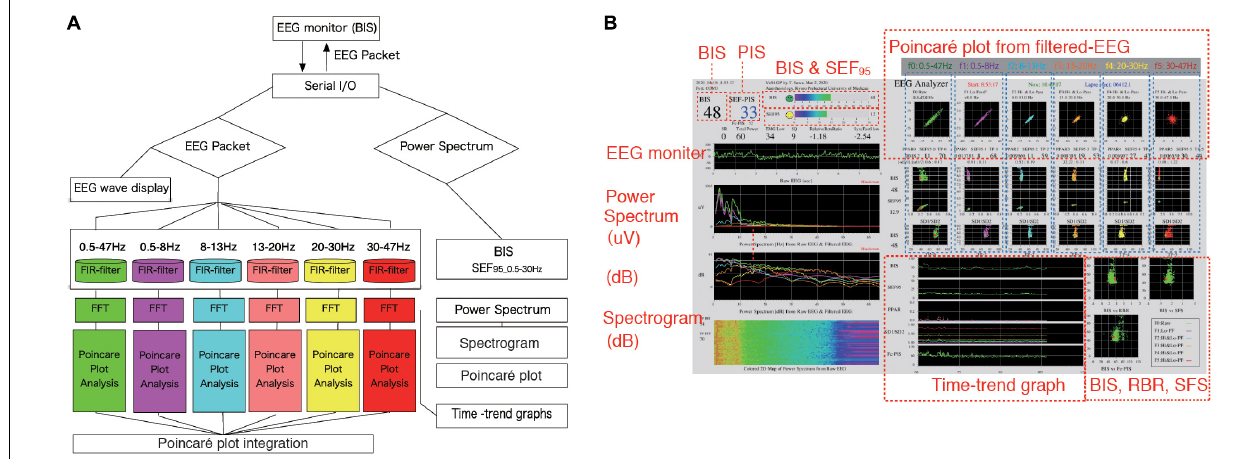
FIGURE 1 | EEG Analyzer software as a real-time monitor of the Poincaré plot. The EEG Analyzer (downloadable for free use from the blog site Science to Medicine, EEG Analyzer ver. 54_GP, http://www.anesth-kpum.org/blog_ts/?p=3169) was developed using the open-source Processing 3.5 software package with the Apache Commons Mathematics Library (version 3.6.1, Apache Software Foundation, Forrest Hill, MD, United States) and a Java Virtual Machine (Oracle, Redwood Shores, CA, United States) with Java class libraries (javax.swing, java.AWT, and java.io packages). (A) Flow chart of on-line Poincaré plot analysis of processed EEG data. EEG waves obtained from the BIS VISTA A-3000 were passed through six bandpass filters for fast Fourier transform frequency analysis. Then, processed EEG data at each filtered range was subjected to Poincaré plot analysis during general anesthesia management. (B) The EEG Analyzer (connected to a VISTA A-3000 BIS monitor to collect EEG packets through an RS-232 interface) displays BIS, SEF 95 , total power, frequency spectrum, and the Poincaré plot of bandpass-filtered EEG data. Digitized EEG packets with a sampling frequency of 128 Hz were obtained through the serial output of the BIS monitor. Eight seconds of EEG analysis yields 1,024 data points, resulting in a Poincaré plot with 1,024 data points. The Fc-PIS shown on the screen was not yet optimized. BIS, bispectral index; EEG, electroencephalogram; Fc-PIS, frequency analysis-cooperated Poincaré plot-integrated score; SEF 95 , spectral edge frequency below 95% of the power of a given signal is located.